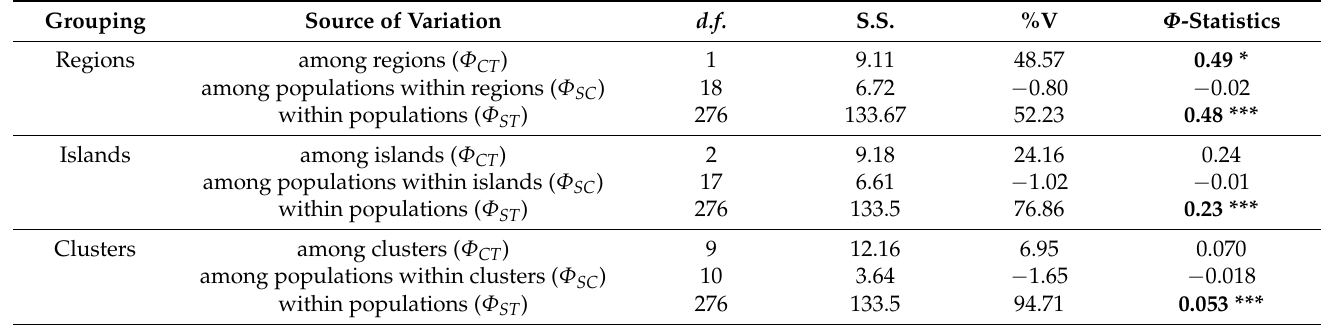
Table 6. Analysis of molecular variance (AMOVA) of Heermann’s Gull cytochrome b , including groupings inferred a prioiri (based on regions, islands, and clusters). For each case, it is showed the source of variation, degrees of freedom ( d.f .), the sum of squares (S.S.), percentage of variation (%V), and Φ -statistics. Significant values are shown in bold (* p < 0.05, and *** p < 0.0001).